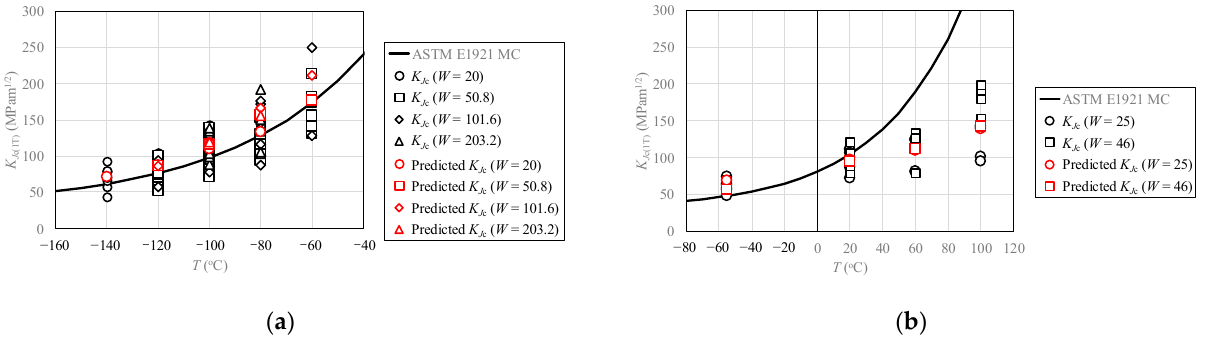
Figure 3. Comparison of K J c of ASTM E1921 MC (solid line) and predicted K J c by the predictor (open red symbols): Dataset used for training model and result of predicted K J c . ( a ) RPV steel (Miura SFVQ1A); ( b ) Meshii FY2017SCM440. K J c pre-dicted by the developed predictor accurately predicted K J c regardless of